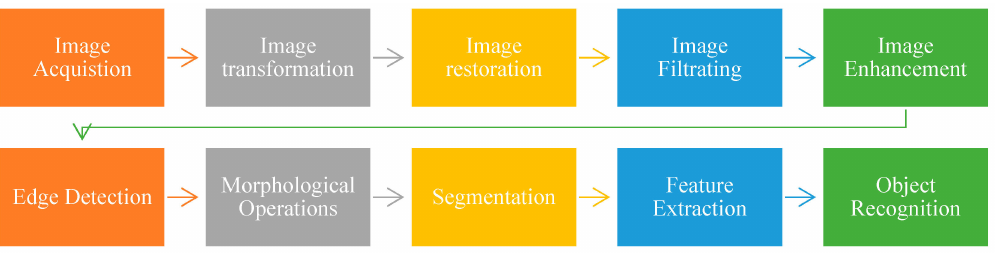
Figure 4. Various Levels of Digital Image Processing [49].